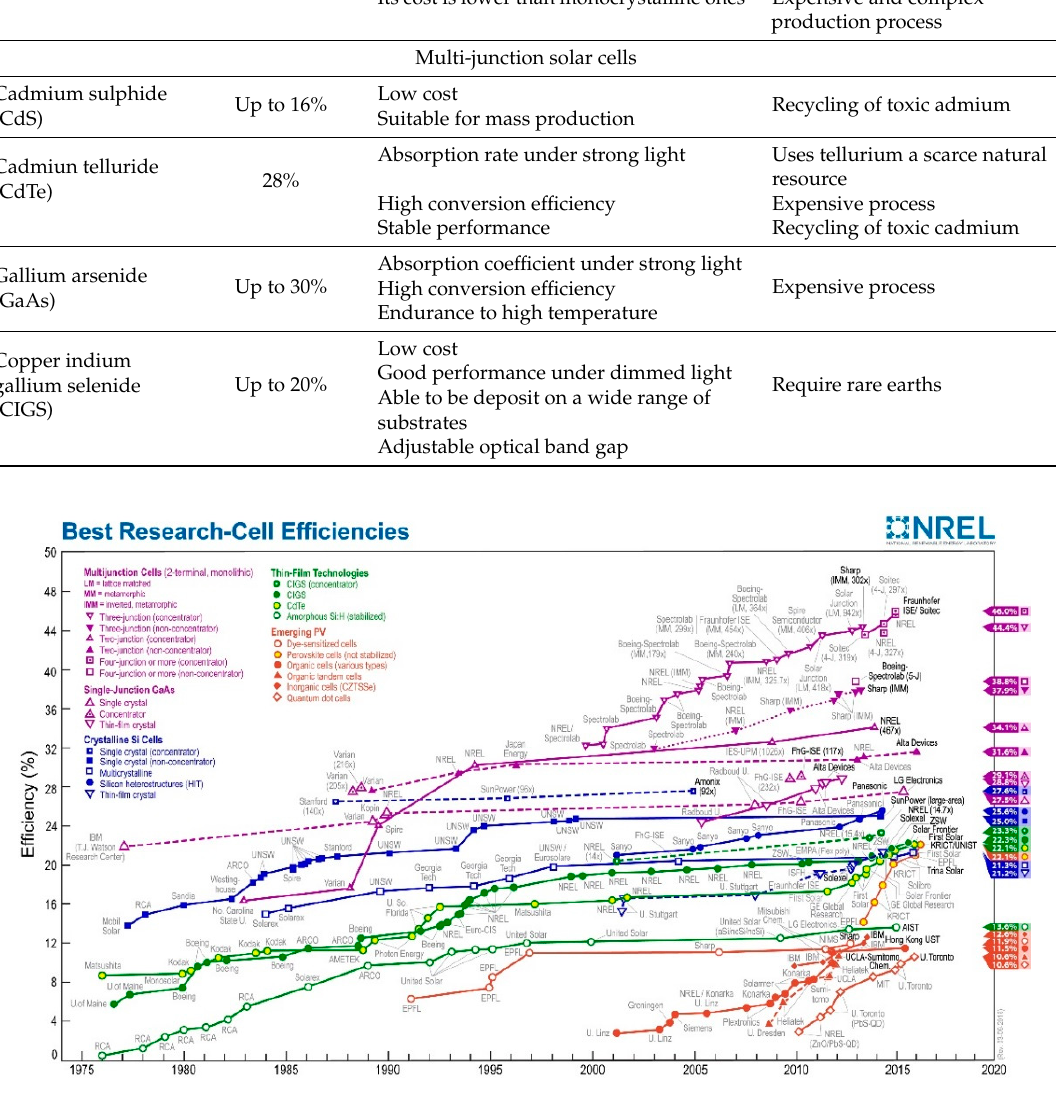
Figure 2. Cell efficiencies research state. Figure 2. Cell e ffi ciencies research